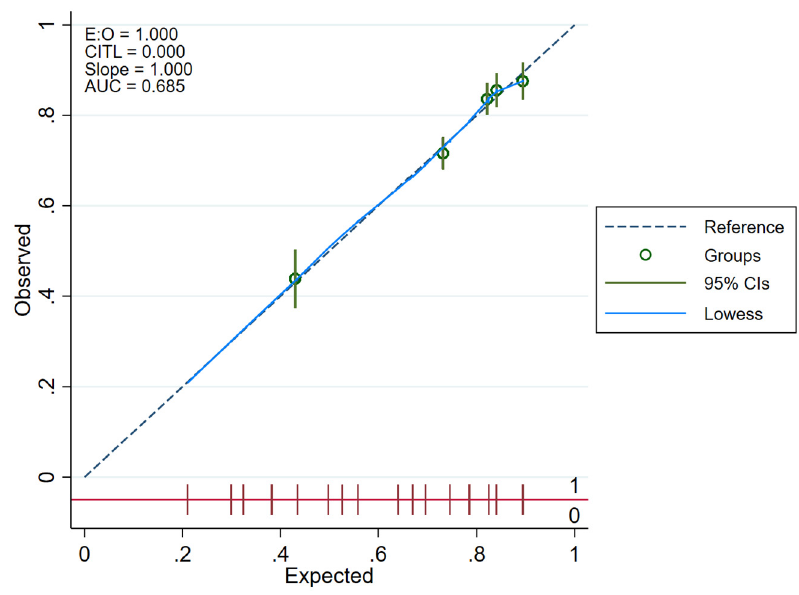
Figure 2. Inpatient mortality post-cardiac arrest in active cancer by Cardiac Arrest Cardio-Oncology Score (CACOS) according to univariable regression ( N = 19,280).